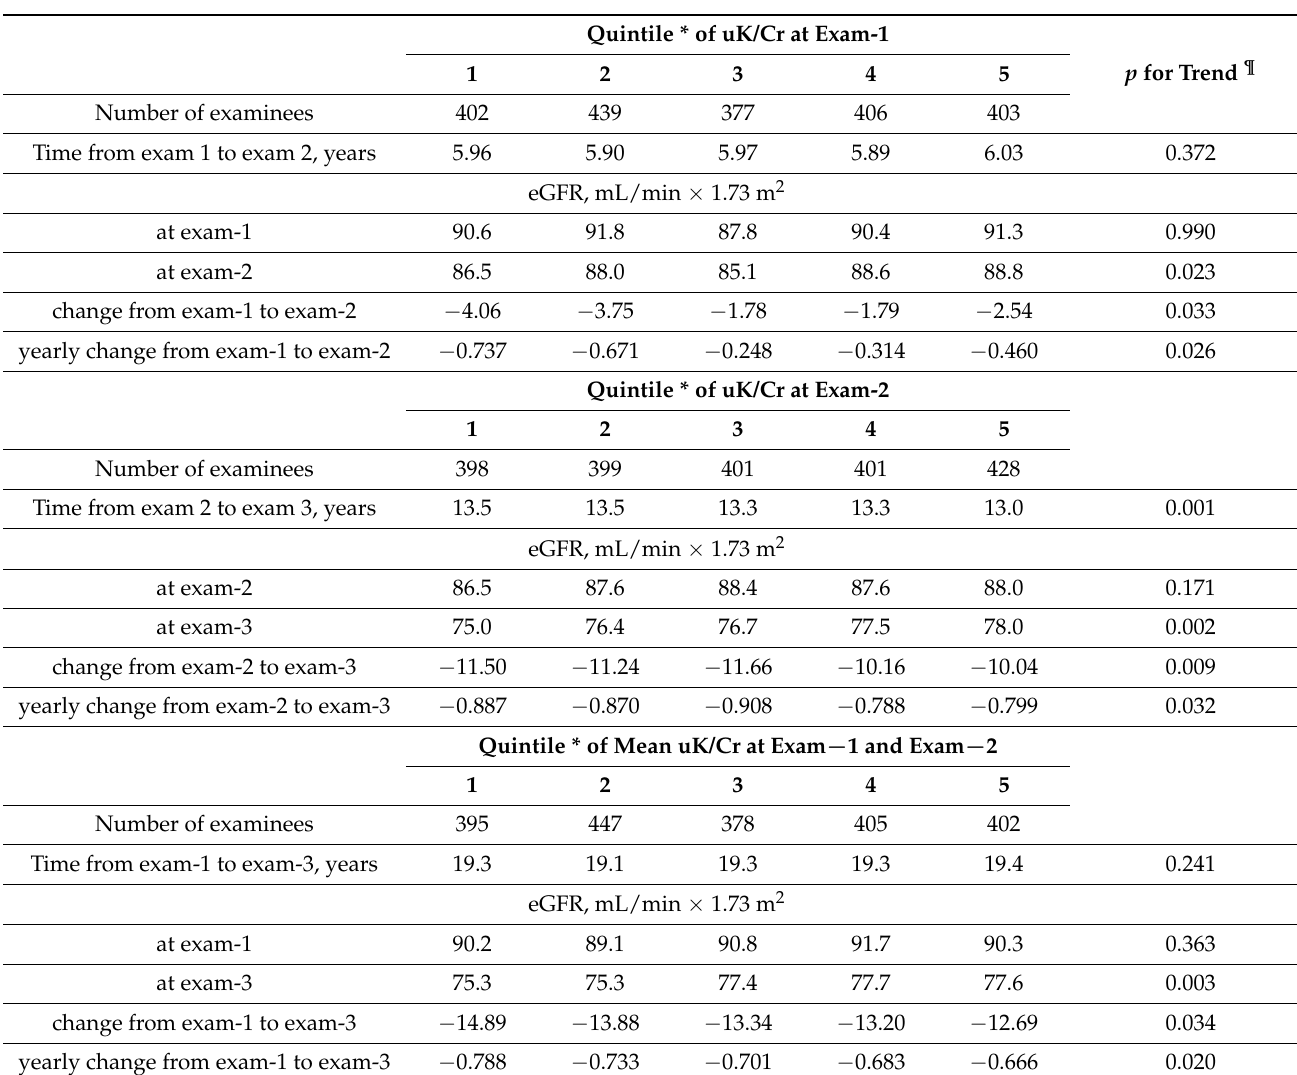
Table 3. eGFR and eGFR changes by quintile of uK/Cr (prevalence or mean).